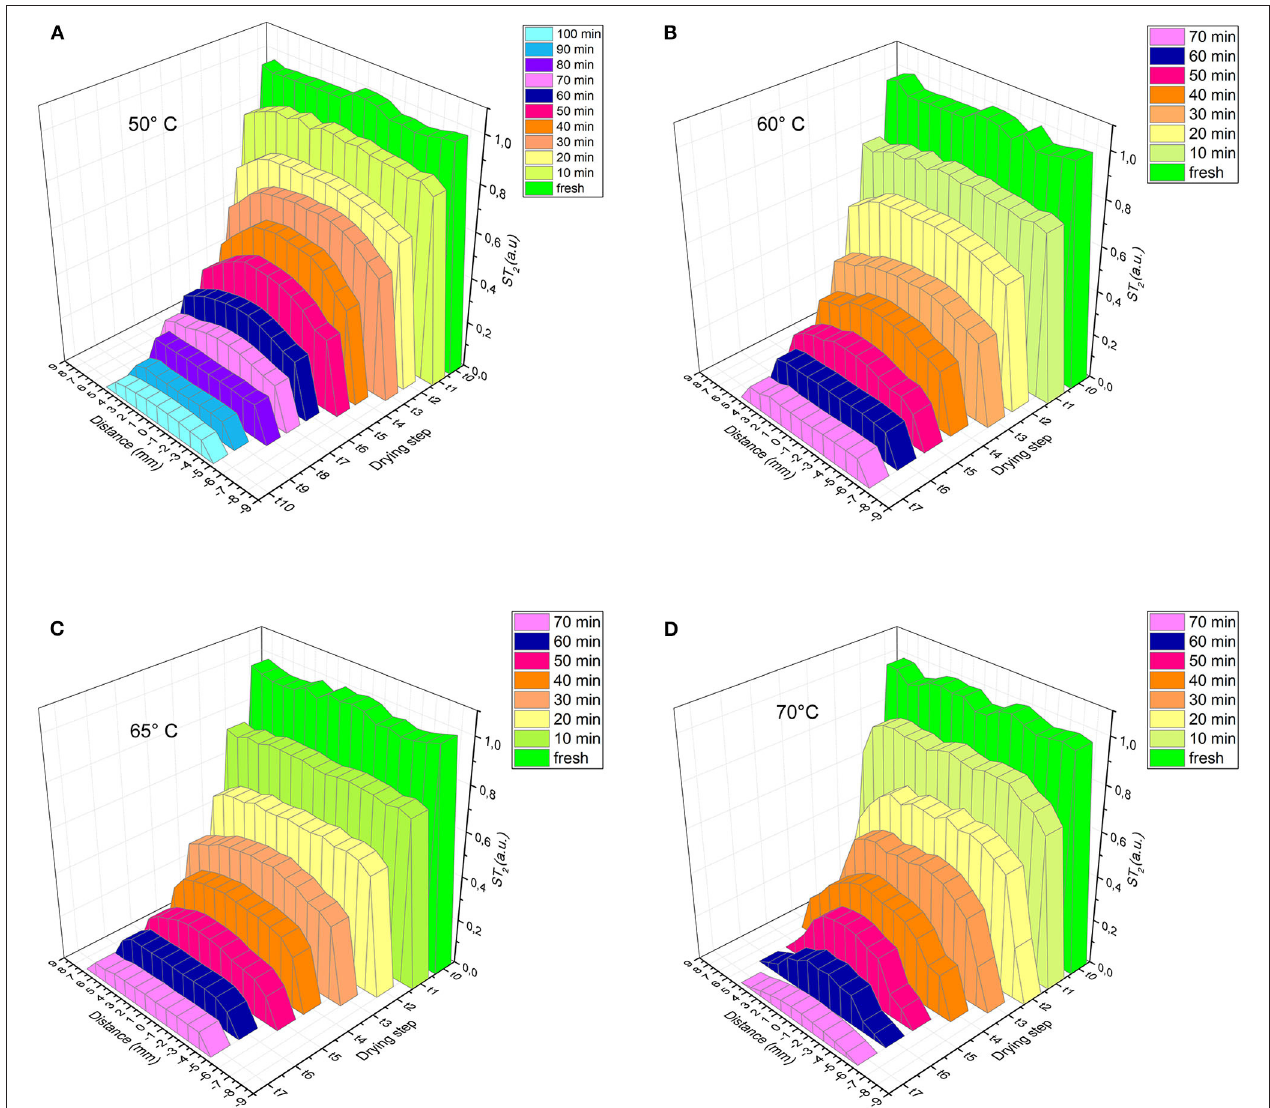
FIGURE 5 | Moisture ratio (a.u.) of samples during drying, obtained by gravimetric method and MRI at (A) 50 ◦ C ( R 2 = 0.995), (B) 60 ◦ C ( R 2 = 0.997), (C) 65 ◦ C ( R 2 = 0.997), (D) 70 ◦ C ( R 2 =